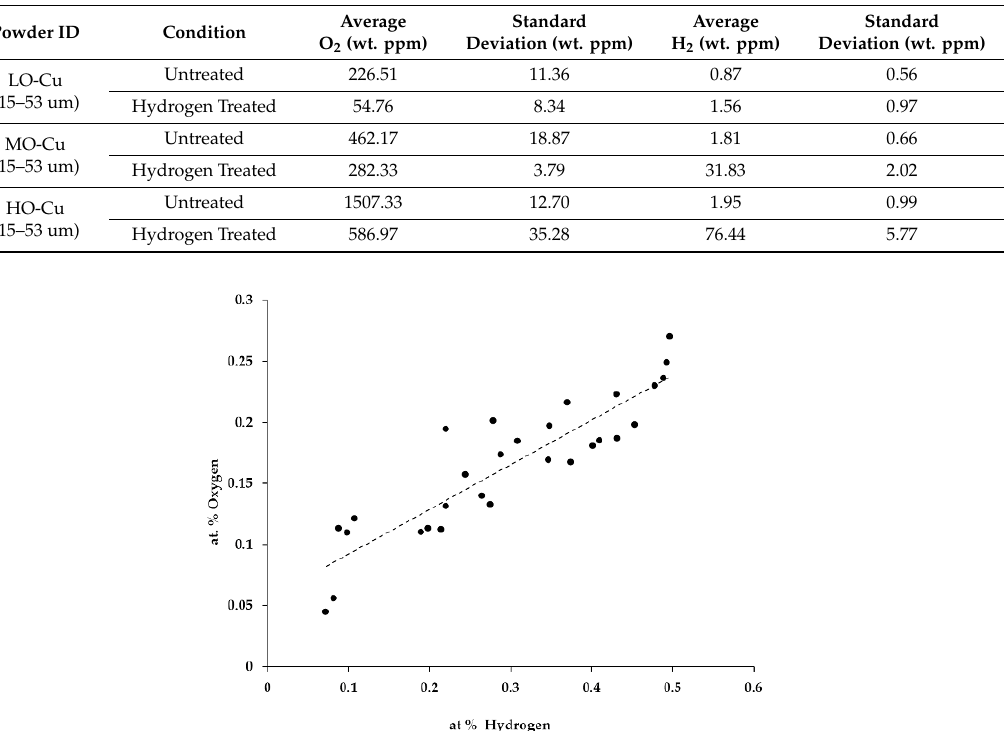
Figure 6. Plot showing the skeletal density of the untreated and hydrogen heat-treated copper powders of varying initial oxygen content, as measured by helium pycnometry.